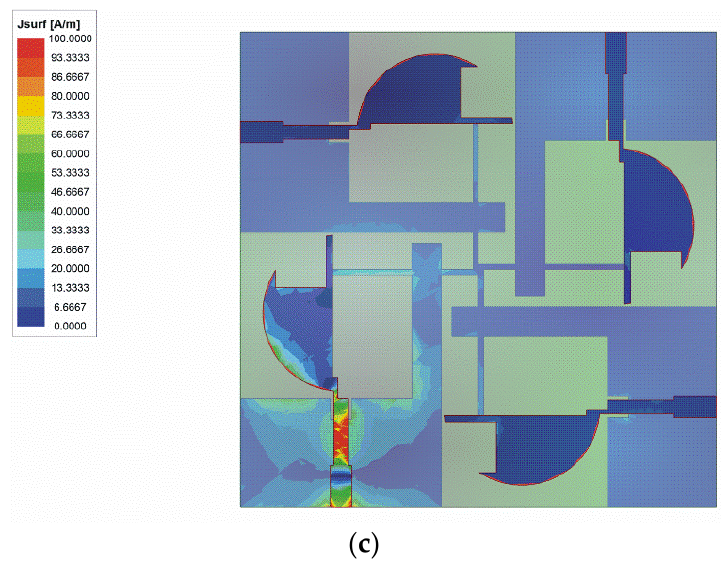
Figure 10. The surface current distribution at: ( a ) 3.5 GHz; ( b ) 7 GHz; ( c ) 10 GHz. DG evaluates the quantified improvement in signal-to-noise ratio when the antennas in the MIMO system receive the RF signal. Equation (2) provides the diversity gain [15].